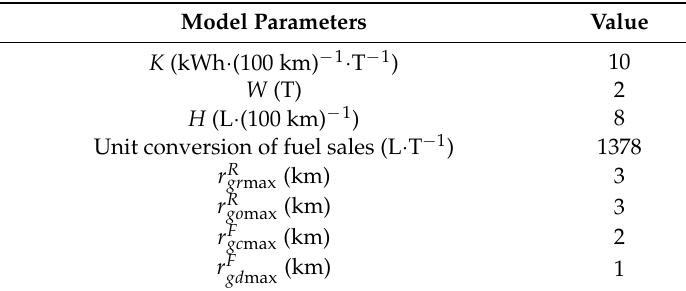
Table 2. The parameters in the load forecasting model.